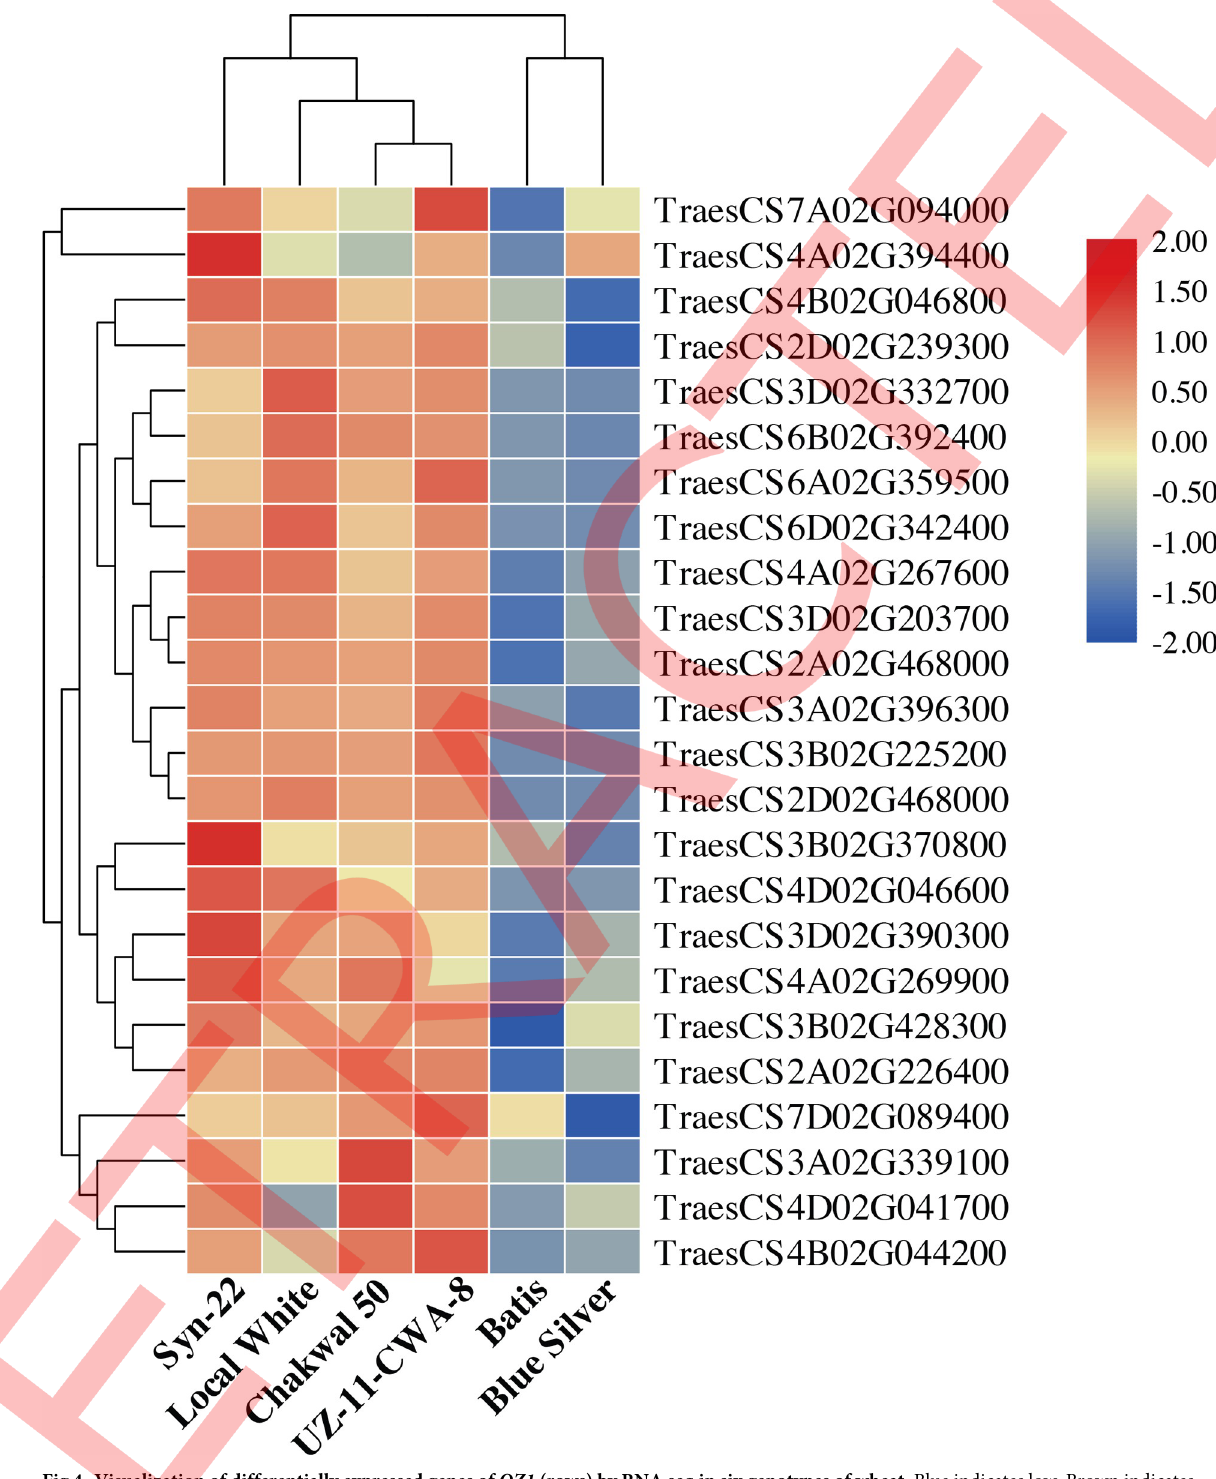
Fig 4. Visualization of differentially expressed genes of OZ1 (rows) by RNA seq in six genotypes of wheat. Blue indicates low, Brown indicates medium red indicates high expression in heatmap.